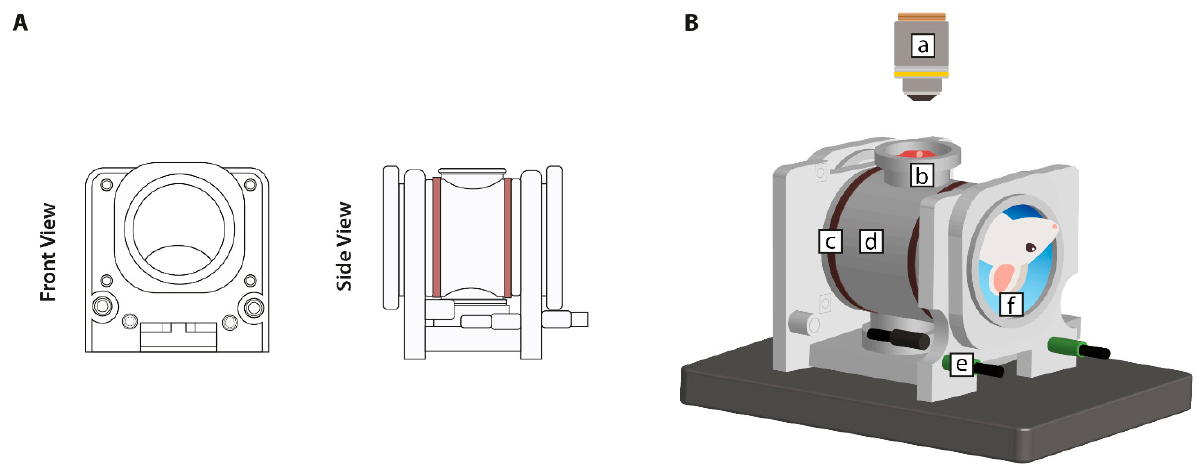
Figure 3. Illustrations of the cylindrical RF device for deep hyperthermia. ( A ) The device consisted of a 3D printed cylindrical base with a hollow bore; semi-circle copper antennas (brown) generated an electromagnetic field, which induced a local temperature increase; ( B ) the CRF set-up consisted of (a) microscope objective, (b) view port, (c) antennas, (d) cylindrical 3D printed frame, (e) coaxial cables, and (f) water bolus.